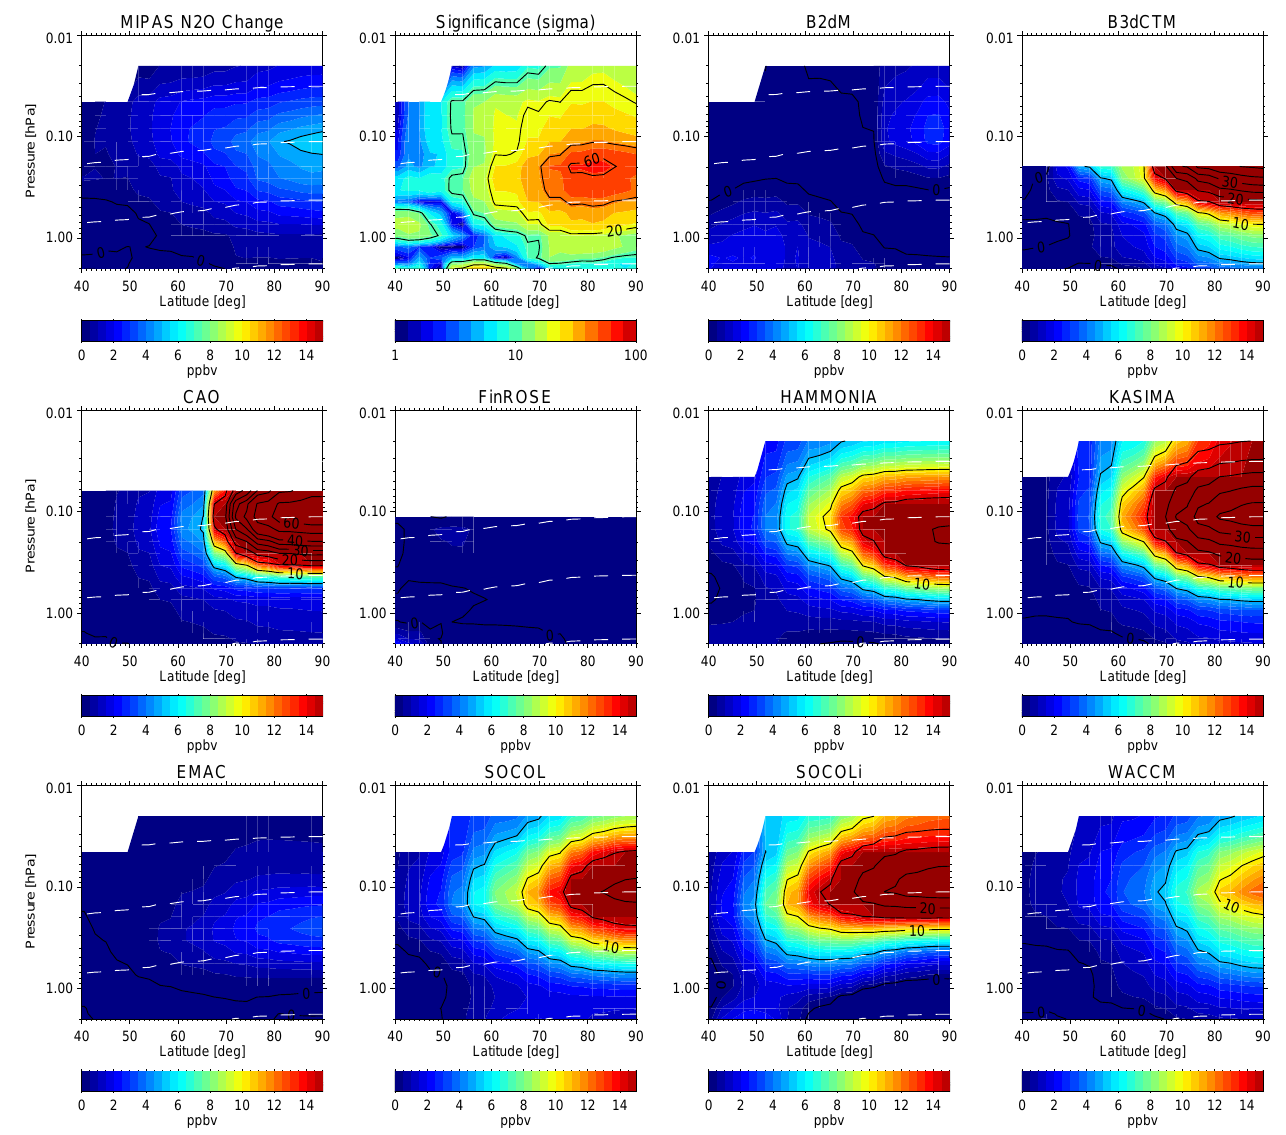
Fig. 18. Zonal mean N 2 O changes with respect to 26 October 2003 in MIPAS observations and model simulations averaged over the period 29–31 October. The significance of observed N 2 O changes (in units of σ ) is shown in the upper second panel (from the left). O changes with respect to 26 October 2003 in MIPAS observations and model simulations averaged over the period Fig. 18. Zonal mean N 2 O changes (in units of σ ) is shown in the upper second panel (from the left). 29-31 October. The significance of observed N 2 giving rise to a NO 2 /NO x ratio close to one in the strato- centrations at high altitudes and/or less efficient mixing be- sphere, but decreasing in the mesosphere due to the availabil- tween polar night and illuminated regions. At sunlit con- ity of atomic oxygen. This decrease occurs at higher altitudes ditions, photolysis of NO 2 and higher atomic oxygen abun- in the polar night region compared to midlatitudes. Figure 19 dances shift the NO 2 /NO x ratio to lower values compared to shows the observed and modeled nighttime NO 2 / NO x ratios dark conditions. Figure 20 shows the observed and modeled averaged over the initial SPE period. The observed decrease daytime ratios. The observed values are well reproduced of this ratio above 0.3 hPa at midlatitudes and 0.1 hPa in the polar region is generally well reproduced by the models which resolve the mesosphere, except for B2dM and EMAC, which both overestimate the polar NO 2 fraction at these al- titudes. The higher mesospheric NO 2 abundances in these two models might be related to lower atomic oxygen con-